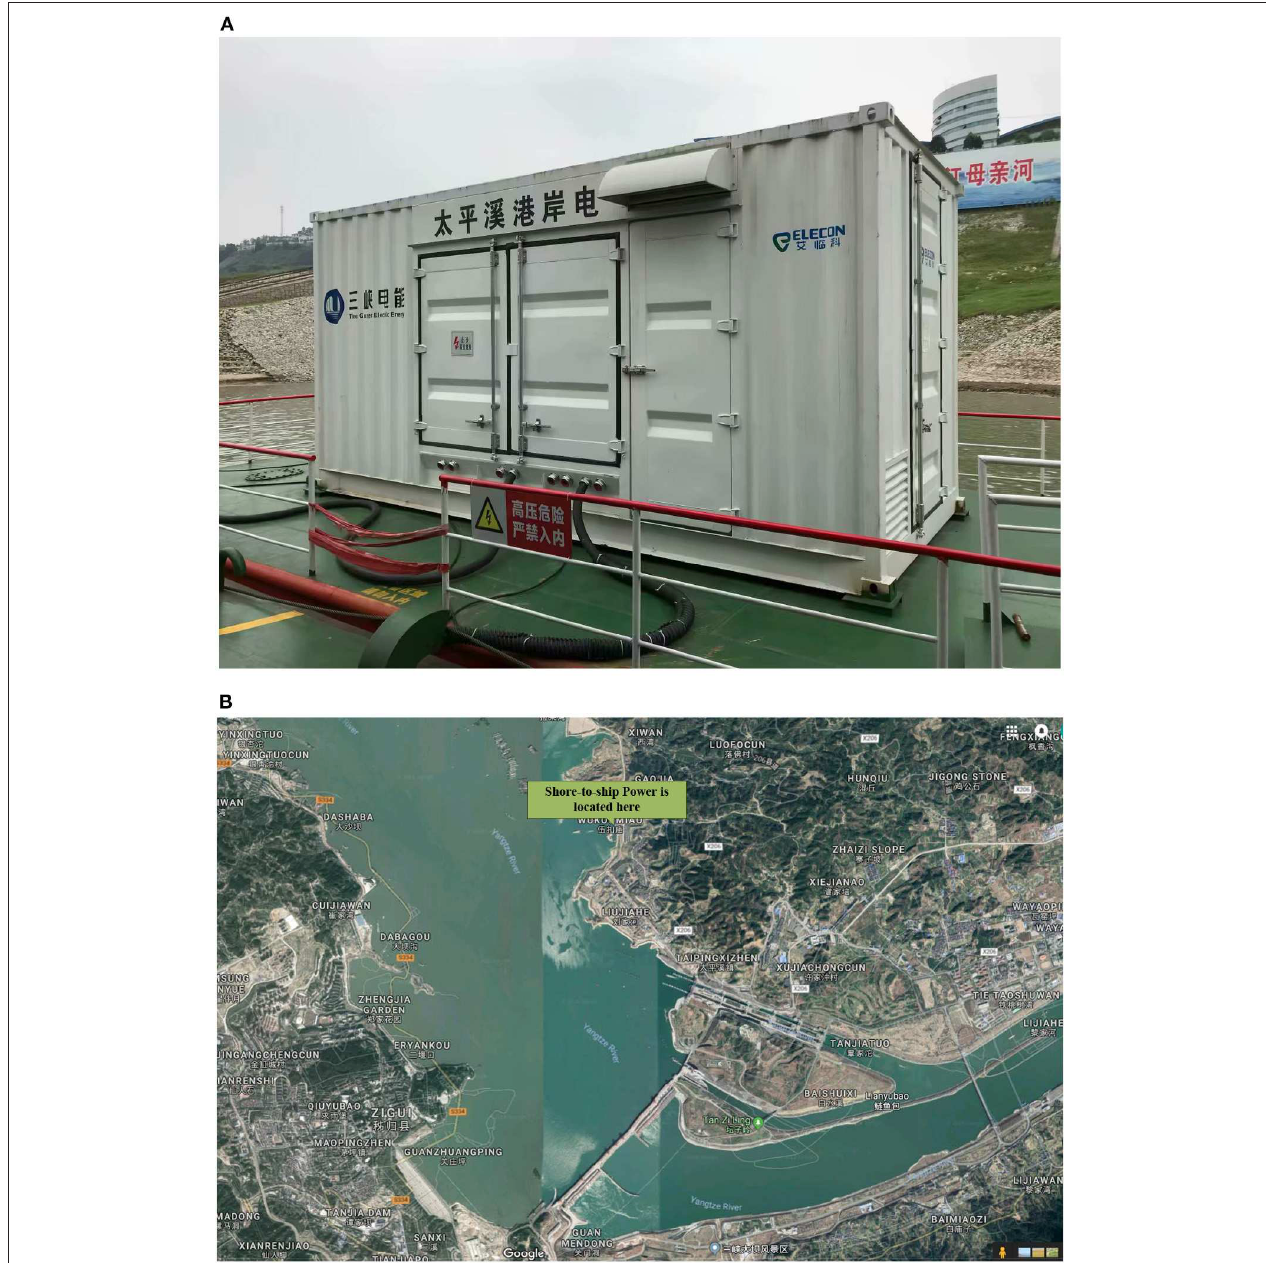
FIGURE 2 | Shore-to-ship power charging piles (China Three Gorges Power Corporation) and a map of their location beside the Yangtze River. (A) Shore-to-ship power charging piles set up by China Three Gorges Power Corporation with no cable lifting device and connection system. (B) The shore-to-ship power charging piles are located on the upper right bank of the Yangtze River Three Gorges Dam.